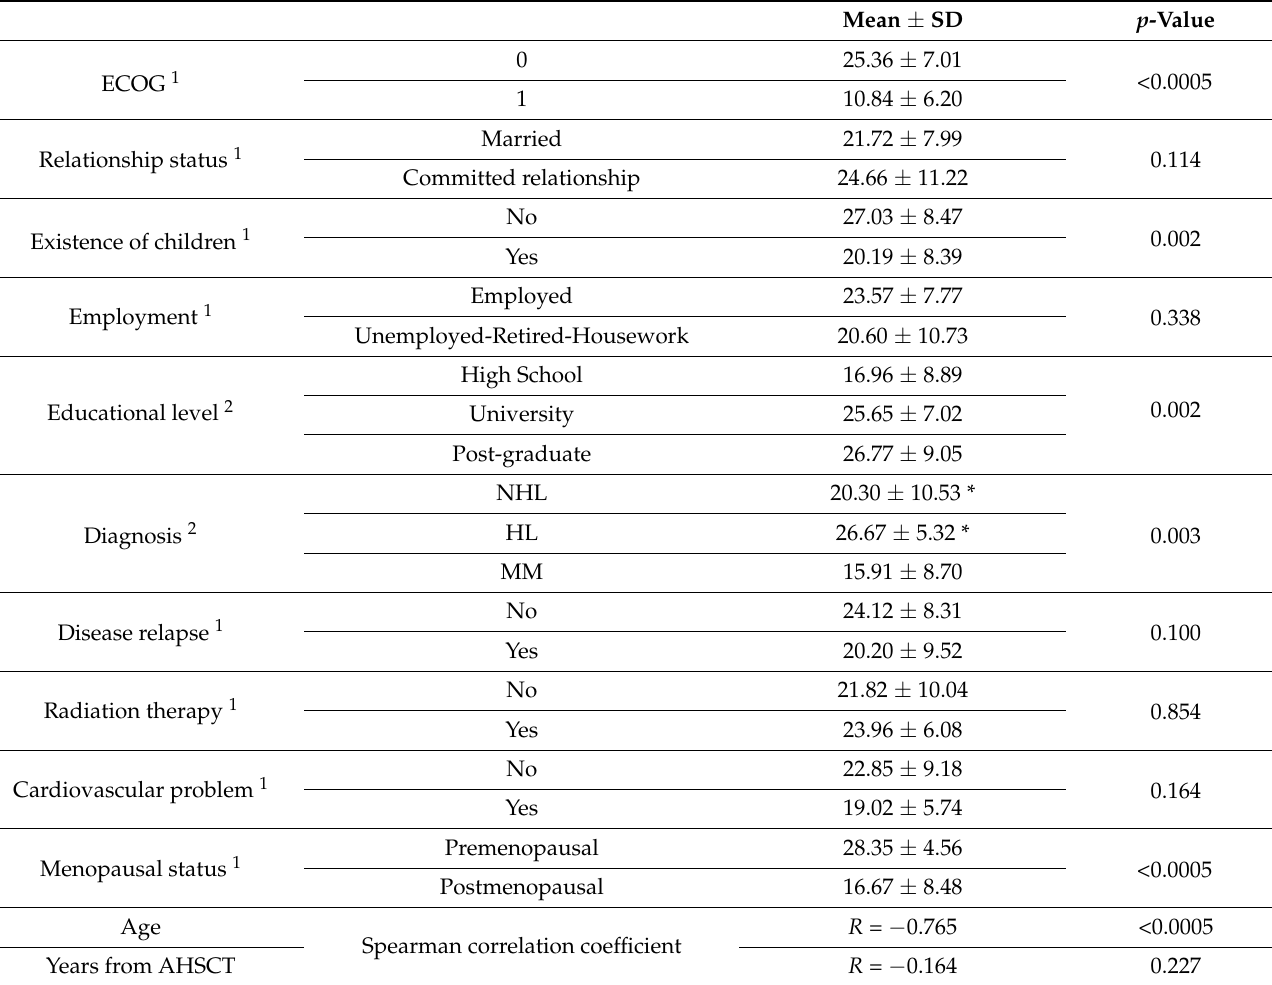
Table 3. Unifactorial analysis of survivors’ total FSFI score with the demographic and clinical